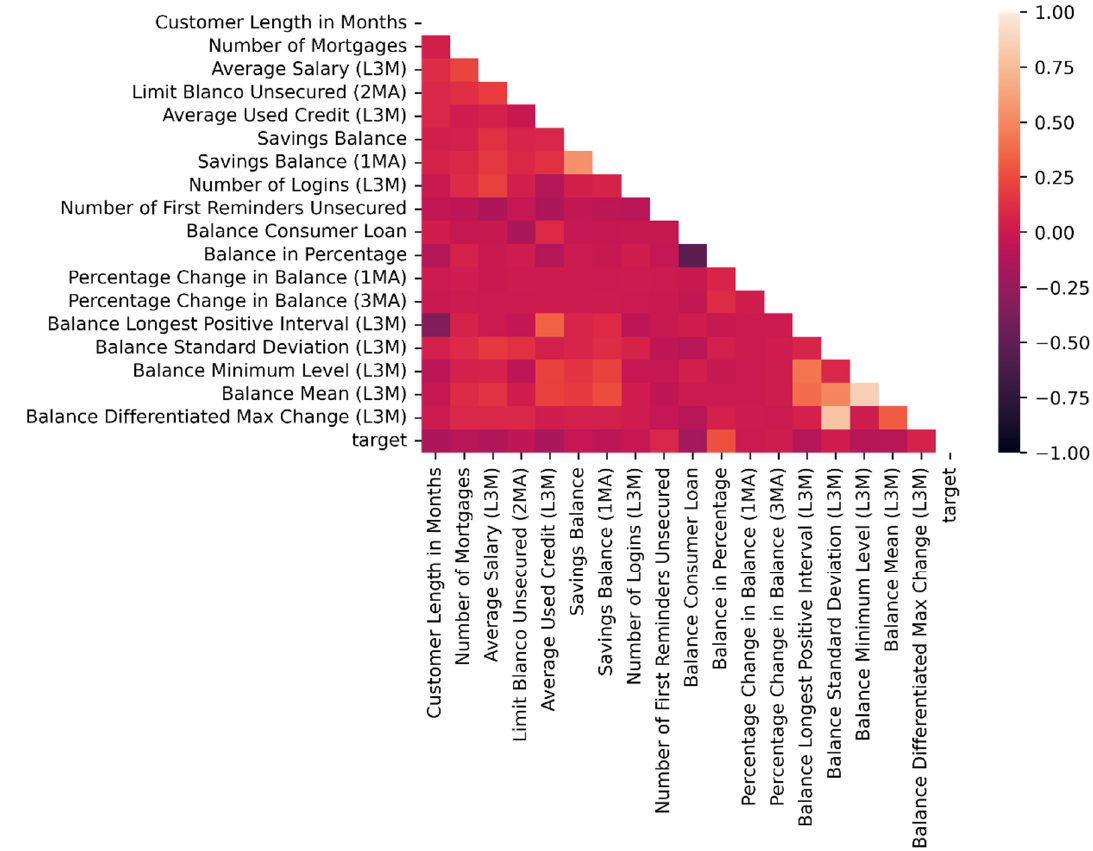
Figure 1. Correlation heatmap of the dataset used by the LightGBM model. The feature combinations are color-coded based on the correlation explained by the color scale to the right. Light colors indicate positive correlations.